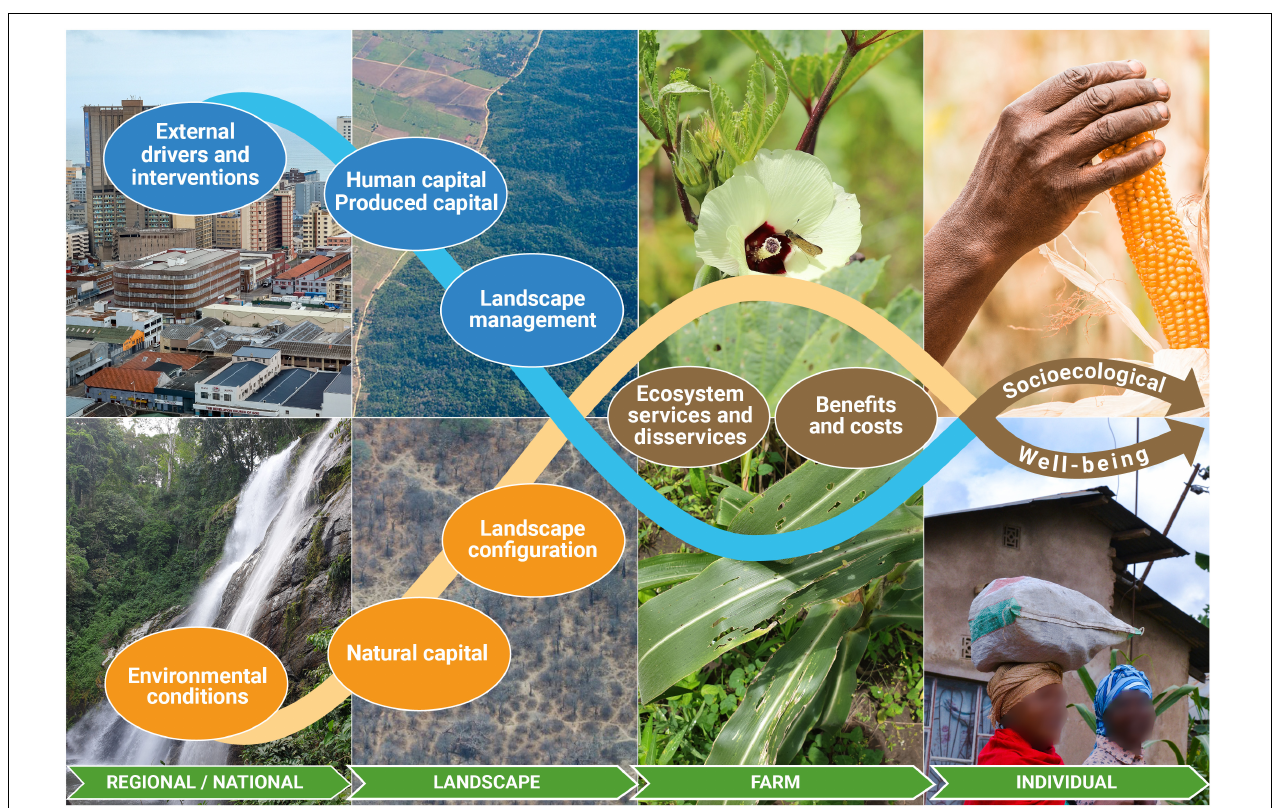
FIGURE 1 | Pathways to socioecological well-being outcomes in forest-agricultural landscapes. The framework integrates across the social and ecological dimensions. It includes interventions and drivers external to the socioecological system, socioeconomic and environmental drivers of change operating at larger spatial scales. While variables can have higher ecological (orange stream) or social (blue stream) leanings, their interaction with natural and other types of capital at landscape level produces impacts on biodiversity and ecosystem service provision (interactions in brown, represented along the middle line), the latter including crop yield. The provision of those services, and trade-offs with disservices, then affects both biodiversity and human well-being outcomes. We use the term “socioecological well-being” to represent both the ecological processes and functions that define self-sustaining ecosystems and the social processes that influence the fulfilment of human needs, individual and communal goals, and a satisfactory quality of life (Brueckner-Irwin et al., 2019). The image of the two women comes from pexels.com with a license that covers its use in this